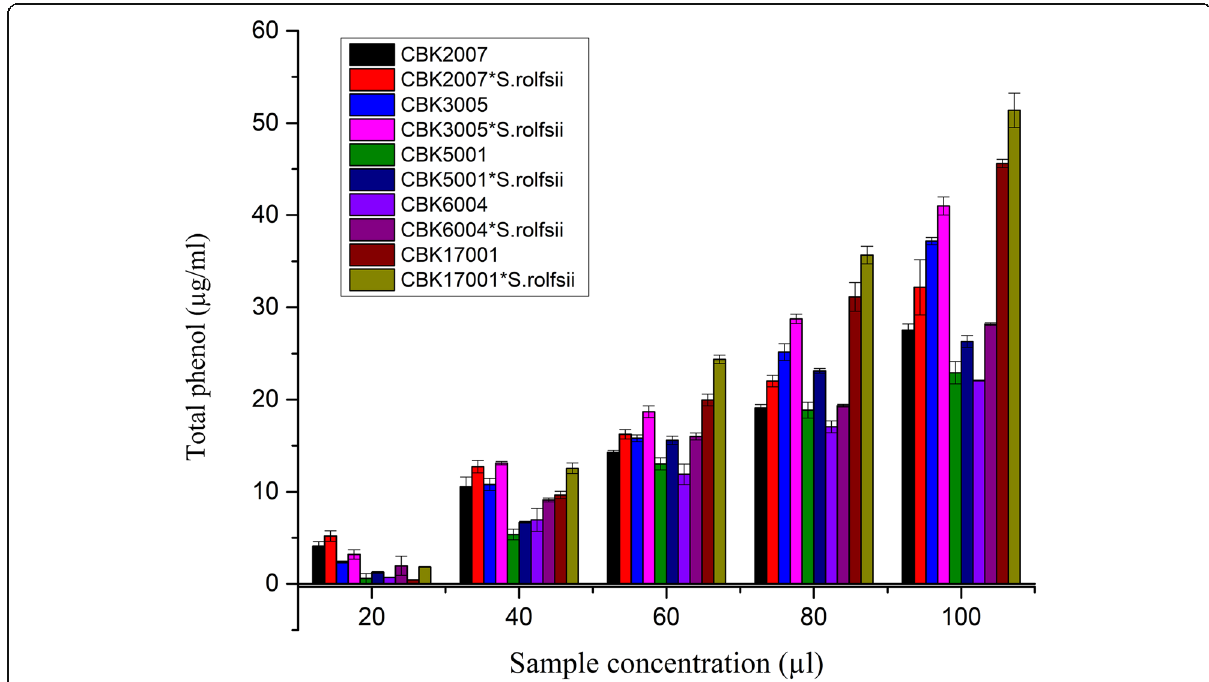
Fig. 3 Total phenol in the culture filtrate of bacterial isolates alone and of their interaction with Sclerotium rolfsii (values are expressed as mean ± SD ( n =